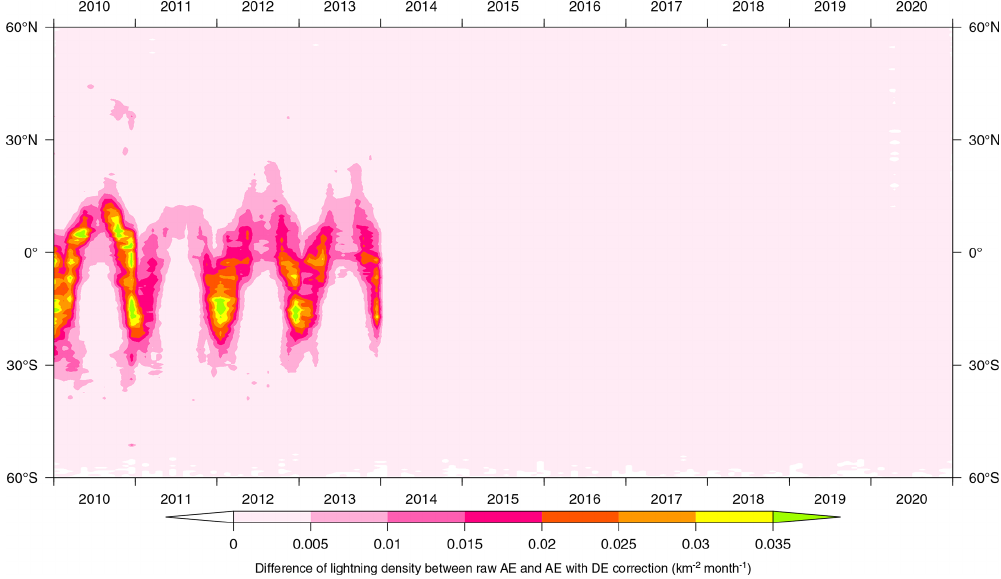
Figure 3. Effects of the WGLC detection efficiency adjustment. The monthly zonal mean differences between the detection efficiency- adjusted WGLC with unadjusted data are shown for 2010–2020. The WWLLN-reported detection efficiency adjustment has its greatest effect in the tropics and Southern Hemisphere subtropics before